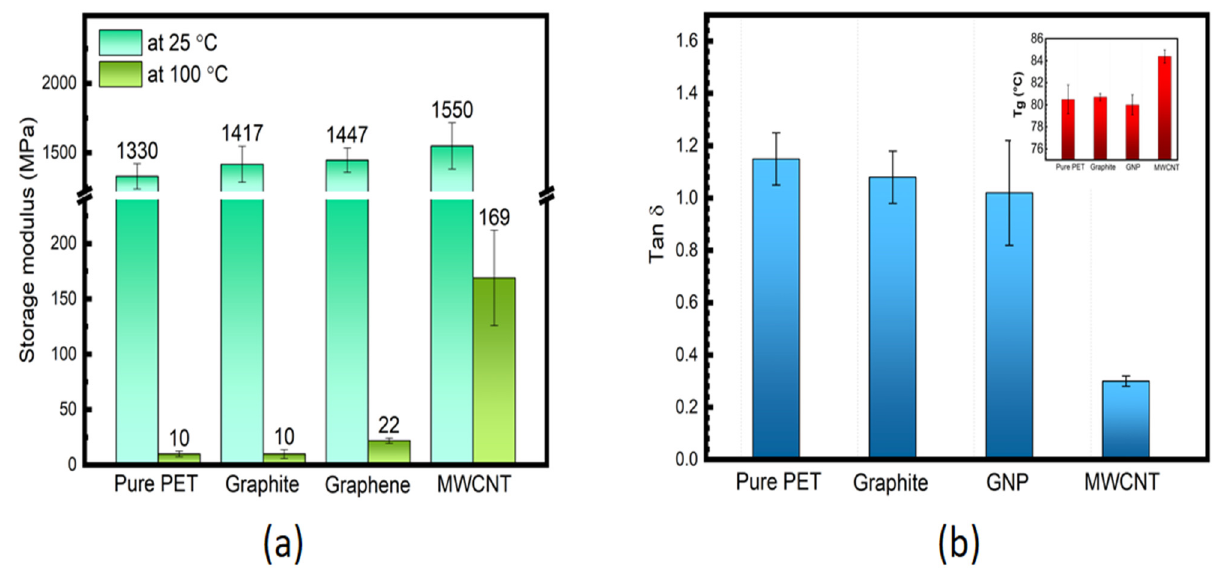
Figure 6. ( a ) Comparison of E’ at 25 and 100 °C and ( b ) tan δ at T g (T g shown in the inset of unfilled PET and composites containing 2 wt. % of graphite, GNP and MWCNT; respectively).